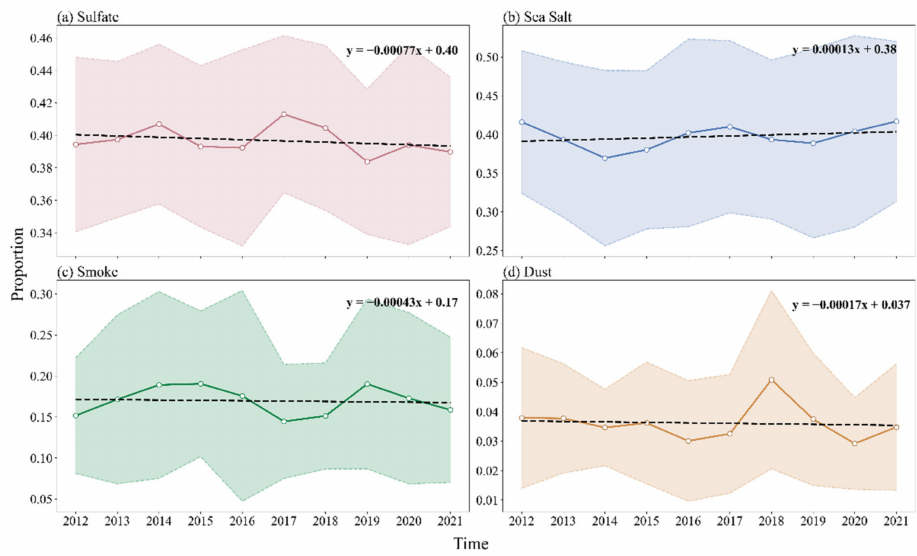
Figure 16. Temporal variations in the annual mean proportion by four components: ( a ) sea salt; ( b ) sulfate; ( c ) smoke; ( d ) dust. The dotted lines represent the fittings of the